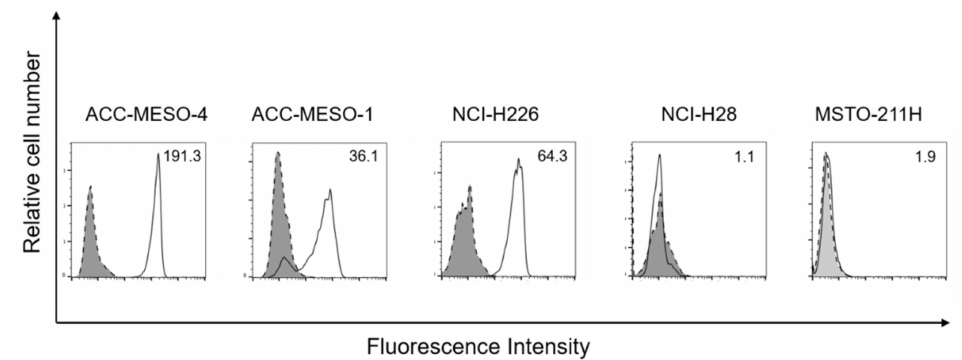
Figure 1. Flow cytometric analysis of podoplanin expression on malignant mesothelioma (MPM) cell lines (ACC-MESO-1, ACC-MESO-4, NCI-H226, NCI-H28, and MSTO-211H). The number in the top right corner in each figure is the mean fluorescein intensity (MFI) ratio.